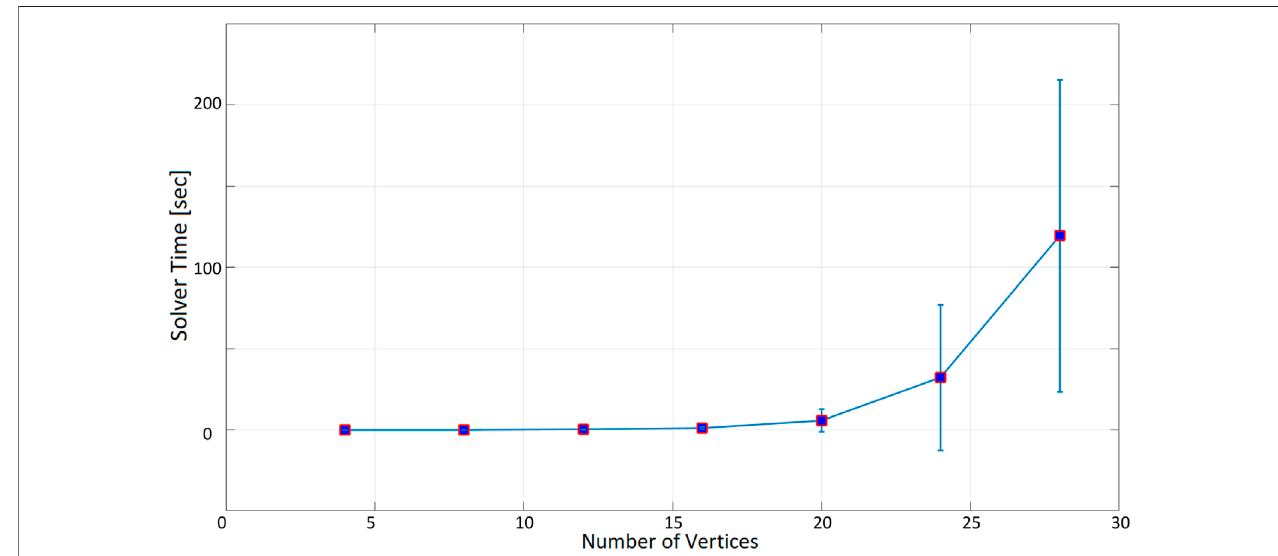
FIGURE 11 | Optimization time (average and standard deviation) versus number of vertices, with the number of targets equal to the number of social charging stations, inspection time spent in targets equal to 180 s.